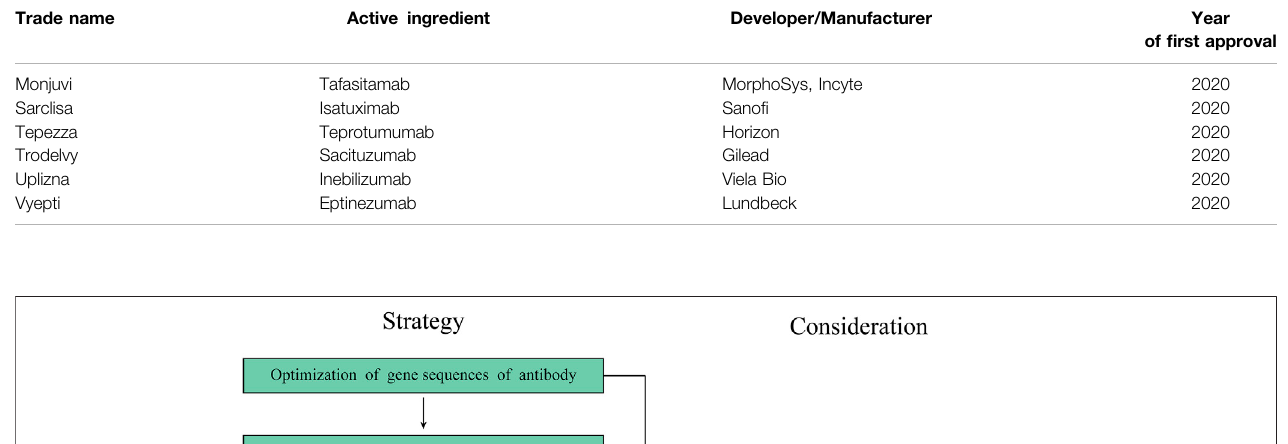
TABLE 1 | ( Continued ) List of approved therapeutic monoclonal antibodies produced in CHO cells.